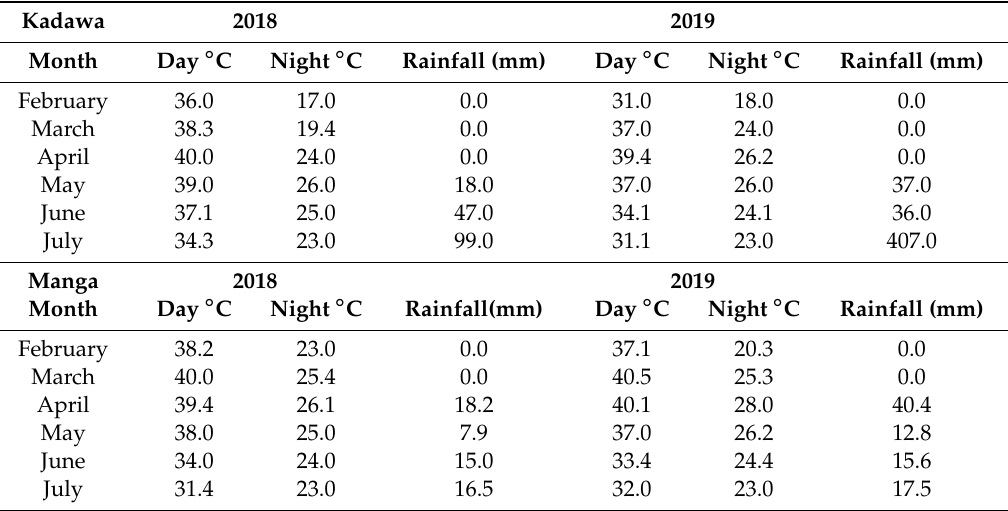
Table 2. Mean monthly rainfall and temperature (day & night) recorded at Manga and Kadawa during the 2018 and 2019 experimental